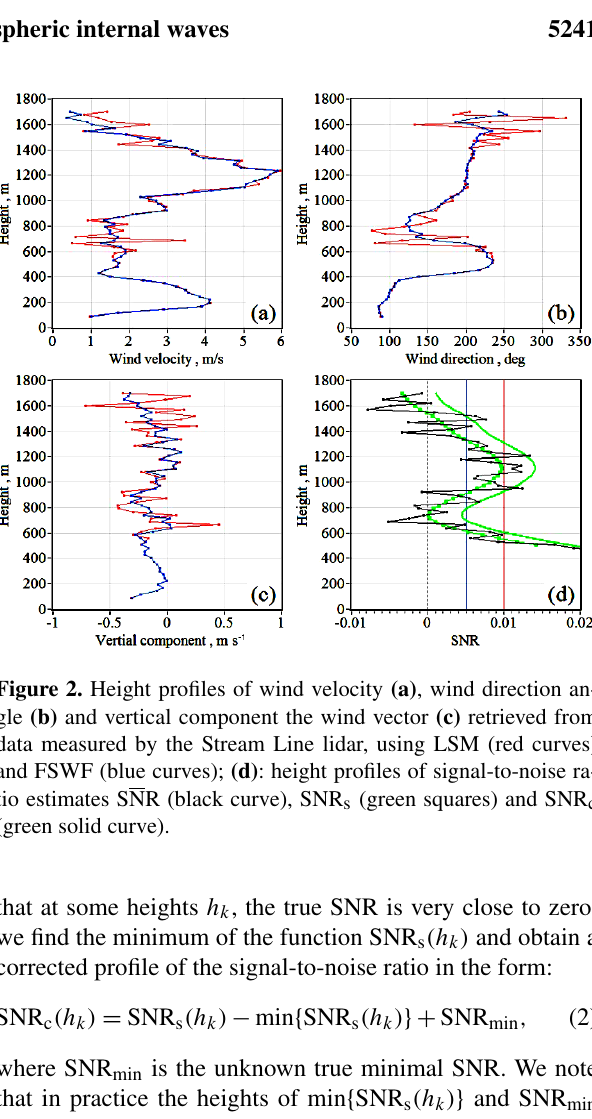
Fig. 2d as a green solid curve. If assumption SNR min = 0 .